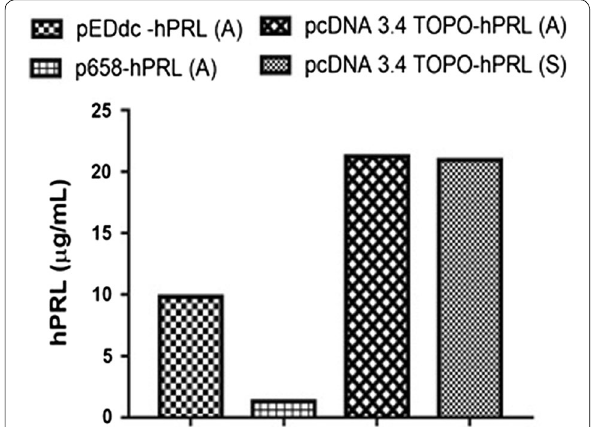
Fig. 1 Expression levels of hPRL by RP-HPLC analysis of conditioned media collected for 4 days from HEK293T adherent (A) and from HEK293F suspension (S) cells, transiently transfected with different